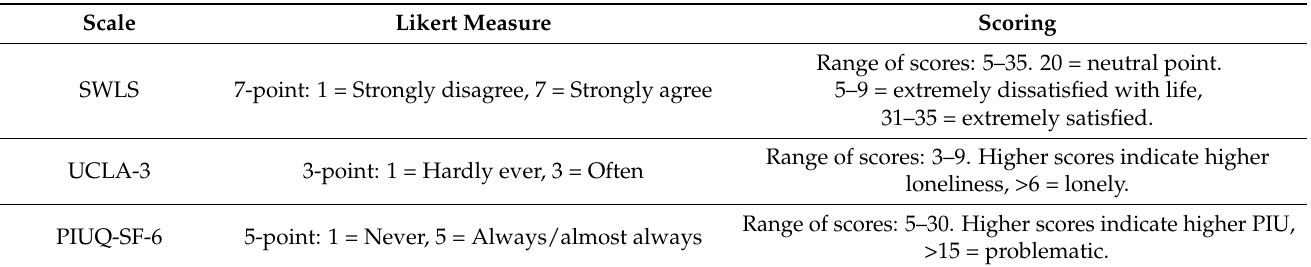
Table 2. Measurement and scoring of each